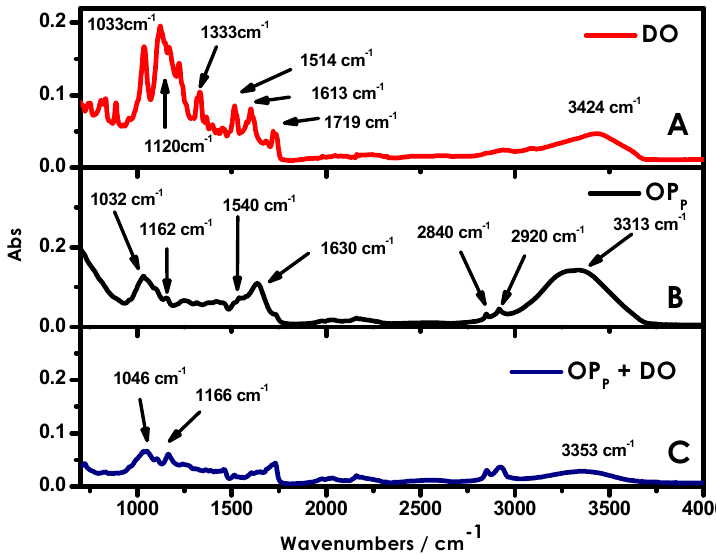
Figure 3. Comparison between detailed views (wavenumbers range: 600–4000 cm -1 ) of FTIR-ATR spectra of DO ( A ); of OP P ( B ) and of OP P + DO composite material ( C ).